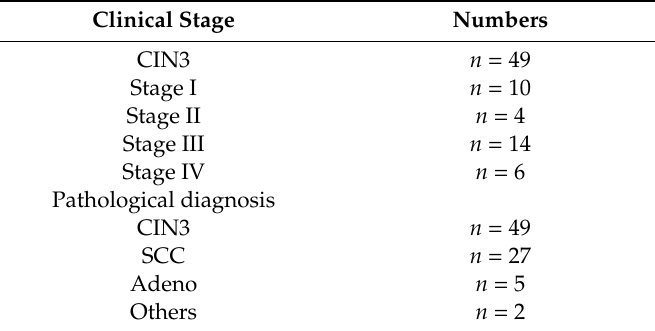
Table 2. Clinical stage and pathological diagnosis of cervical lesions / tumors.